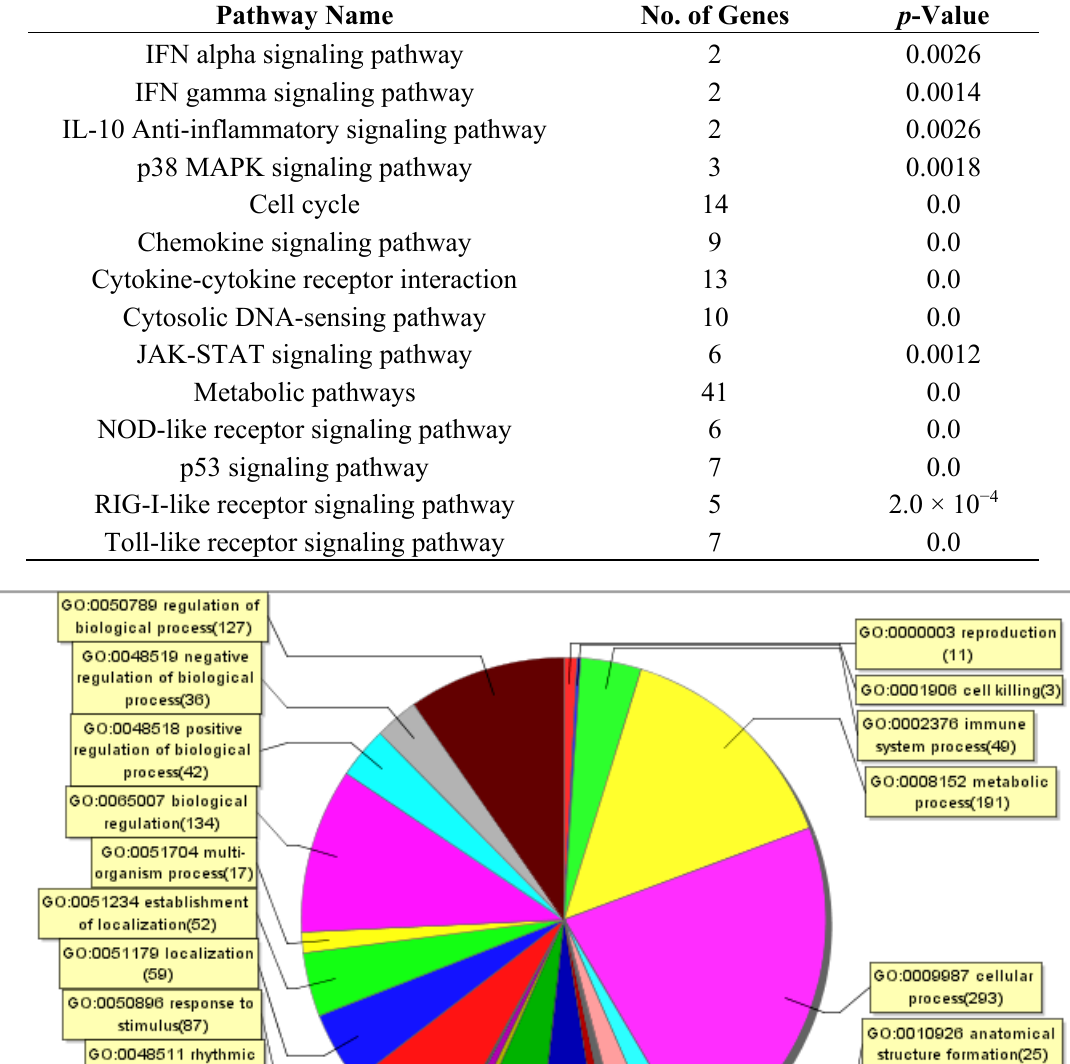
Table 2. Significant pathway of the differentially expressed genes in Japanese encephalitis virus (JEV)-infected Raw264.7 cells.